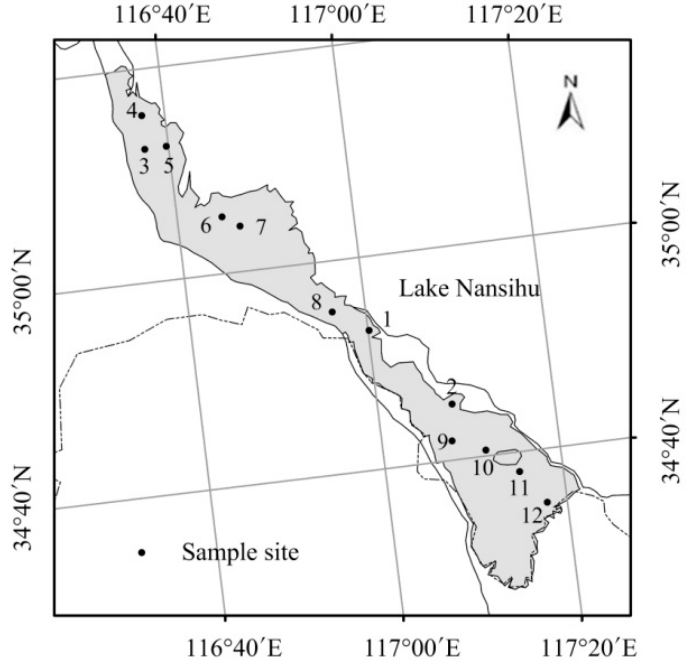
Figure 1. Location of Lake Nansihu and sampling sites in the lake. The figure was made by ArcGIS version 10.0 (ESRI, Redlands, CA, USA).